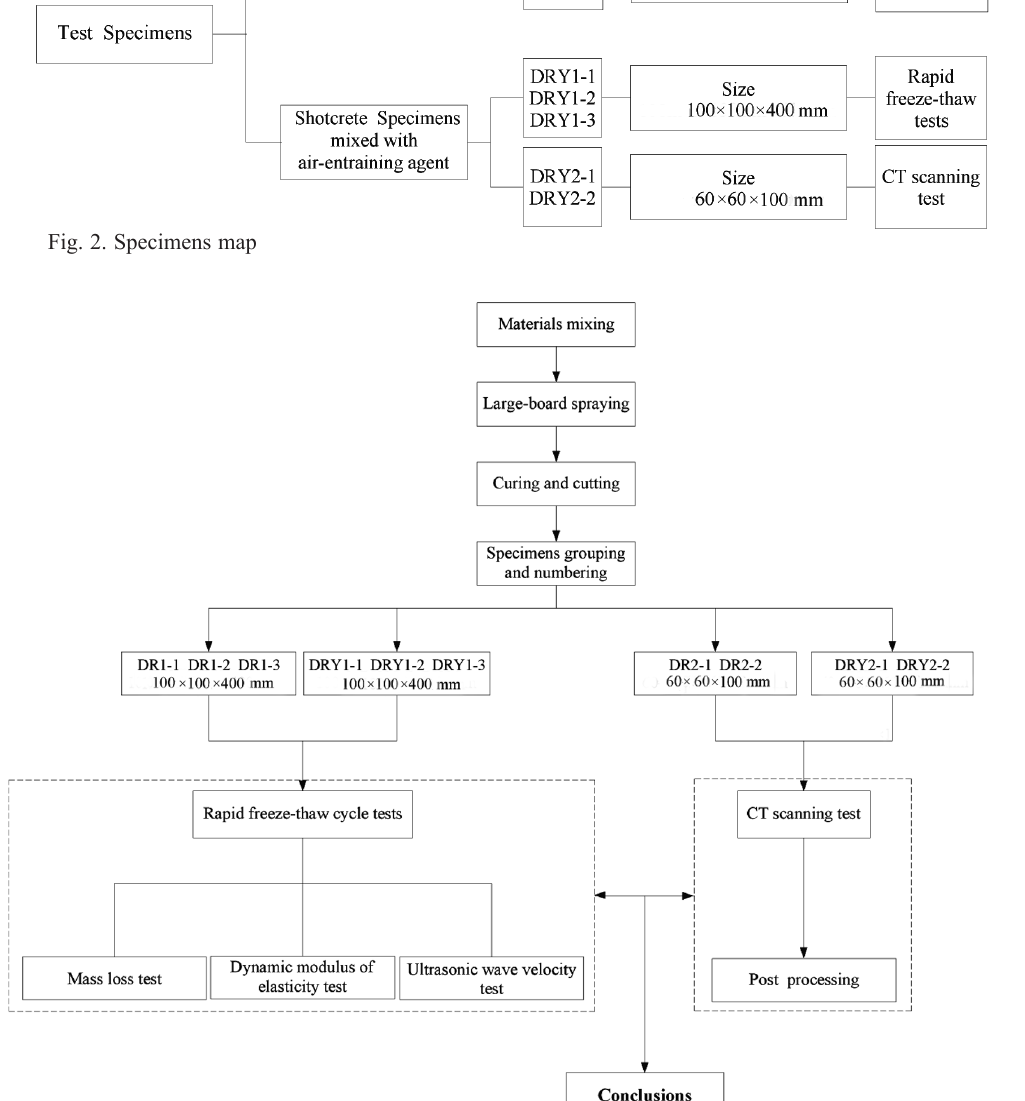
Fig. 3. Technology roadmap of the